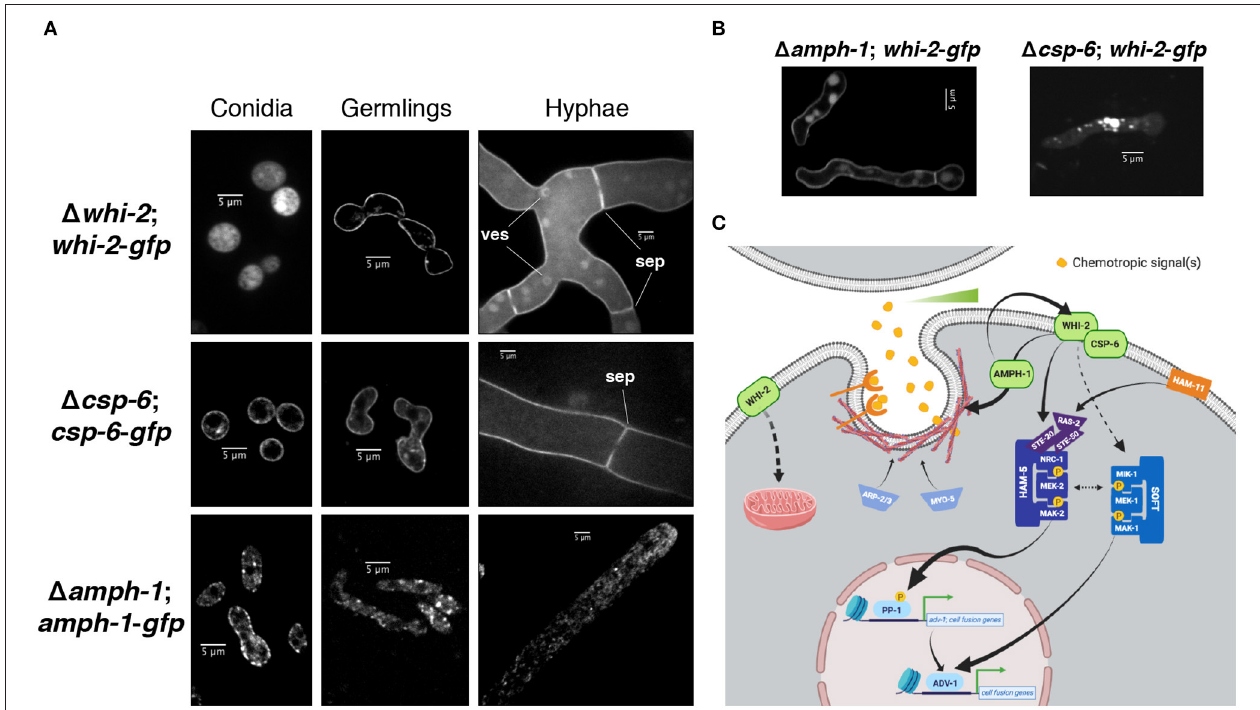
FIGURE 6 | Localization of WHI-2, CSP-6 and AMPH-1 at different asexual stages. (A) The localization of WHI-2 (upper panel), CSP-6 (middle) and AMPH-1 (lower) was examined in the deletion strains carrying a GFP-tagged construct of the respective protein. Panels from left to right indicate conidia, germlings and mature hyphae. ves, intracellular vesicle membrane; sep, septum. (B) Localization of WHI-2 in 1 amph-1 and 1 csp-6 mutant background. (C) Schematic model of the role of WHI-2, CSP-6, and AMPH-1 in signal reception during cell-cell communication of N. crassa germlings. Sensing of a gradient of the chemotropic signal(s) may occur via endocytosis of the chemotropic signal or via internalization of a receptor. WHI-2 and CSP-6 interact and sit at the cell periphery. AMPH-1 could be involved in vesicle scission during endocytosis and is epistatic to WHI-2. WHI-2 may also play a role in one or more steps of endocytosis, potentially via AMPH-1. WHI-2 functions upstream of the NRC-1/MEK-2/MAK-2 signaling pathway. Previous western blot data (Fu et al., 2014) indicated that WHI-2 could also affect signaling through another MAPK pathway composed of a MIK-1/MEK-1/MAK-1 module. These two MAPK cascades are involved in the activation of the transcription factors PP-1 and ADV-1, which directly regulate the expression of genes involved in cell communication and fusion. WHI-2 also controls the organization of the intracellular mitochondrial network. For simplicity, a number of signaling components and phosphorylation events have been left out (Please see Fischer and Glass, 2019, for an extended